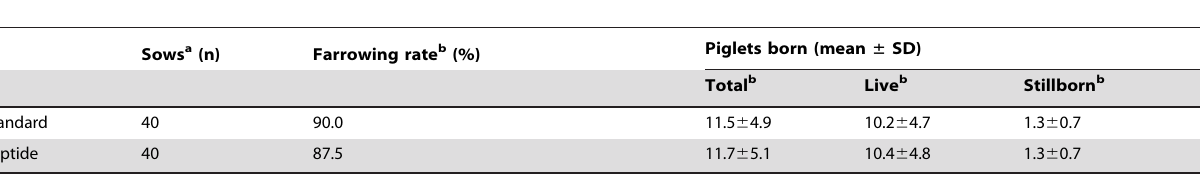
Table 3. Fecundity results with semen diluted in BTS + 250 m g/mL gentamicin (standard) and 16 m g/mL gentamicin + 4 m M c-WFW